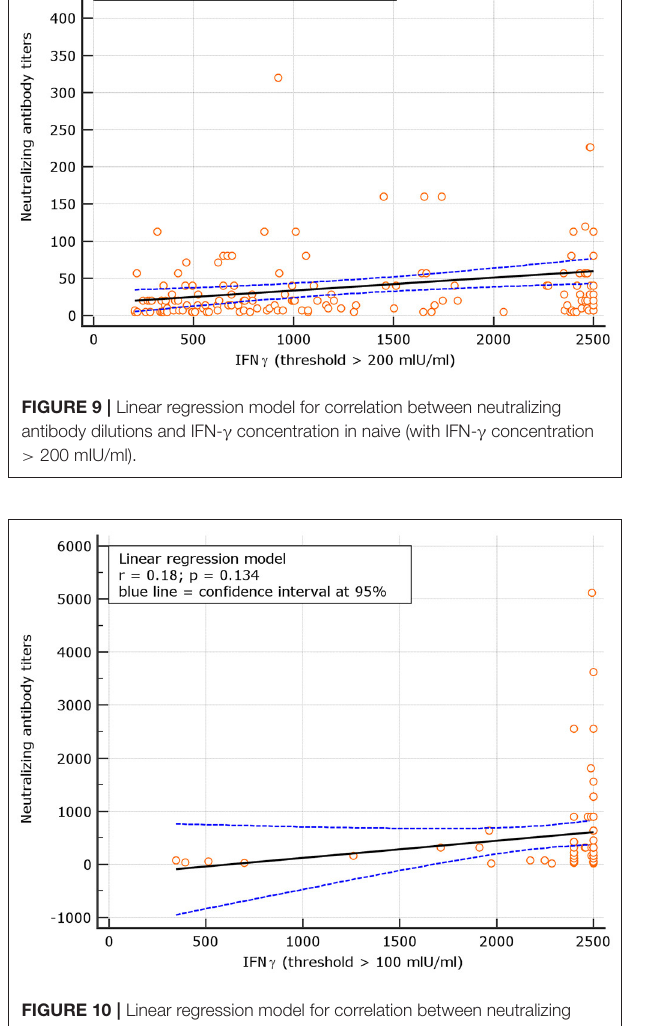
FIGURE 10 | Linear regression model for correlation between neutralizing antibody titers and IFN- γ concentration in experience (similar results for IFN- γ threshold of 100 and 200 mIU/ml given the identical number of subjects above these thresholds among experienced).